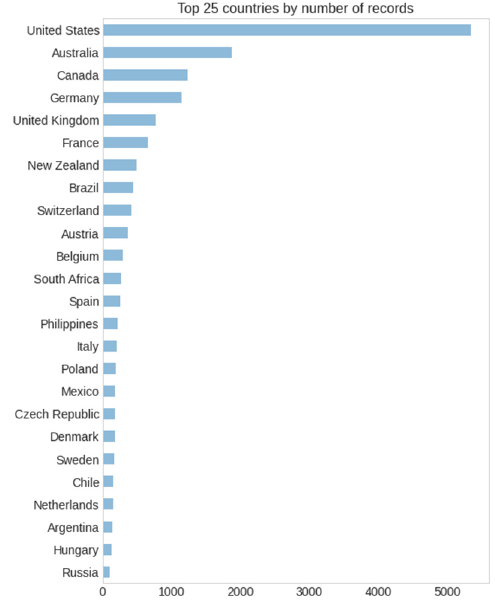
Figure 5. Top 12 countries by number of records.